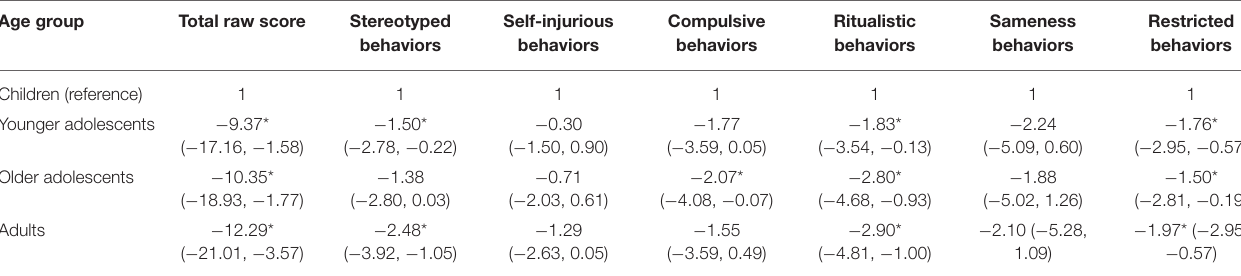
The statistics show β and 95% confidence interval. RRBIs, restricted and repetitive behaviors and interests. The models adjusted for sex, age, FIQ, eye status during scan and current medication status. * p < 0.05.